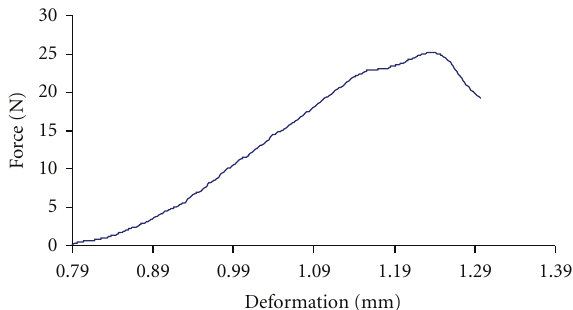
Figure 3: Typical force-deformation characteristics of pumpkin seed.